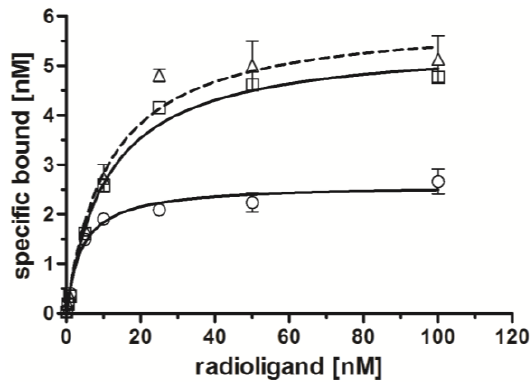
Figure 3. Specific receptor saturation binding to PC-3 cells; [ 99m Tc(CO) line), [ 99m Tc(CO) ( 15 )] (∆, dotted line), [ 99m Tc(CO) 3 to 10 6 cells per well; n = 2–3 (in triplicates, reported by means ± SD, and calculated by non-linear regression using GraphPad Prism